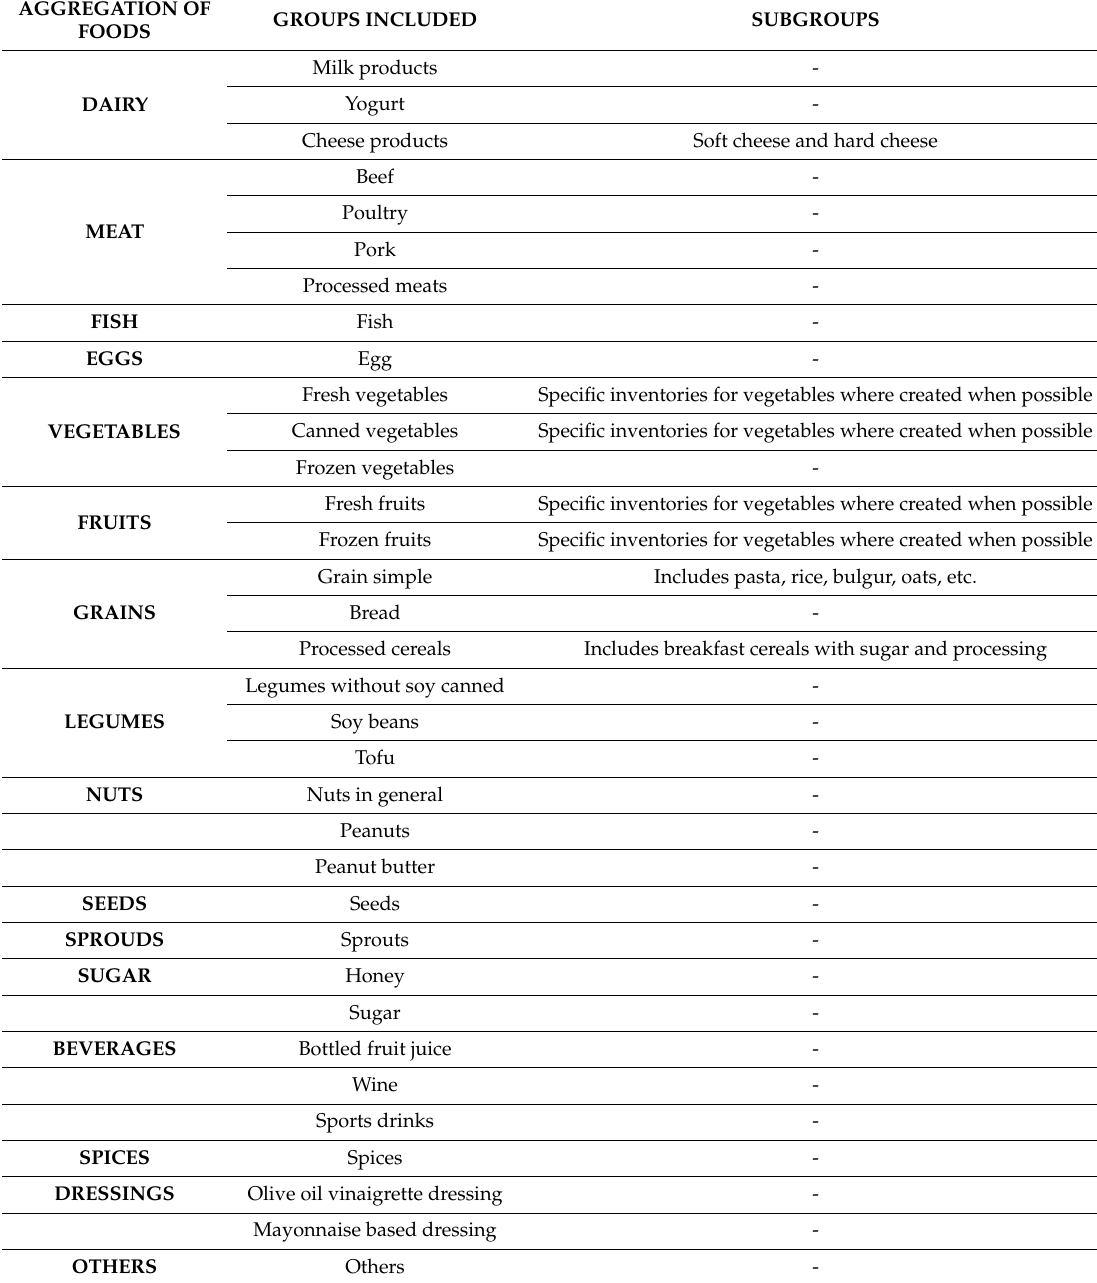
Table A1. Food group